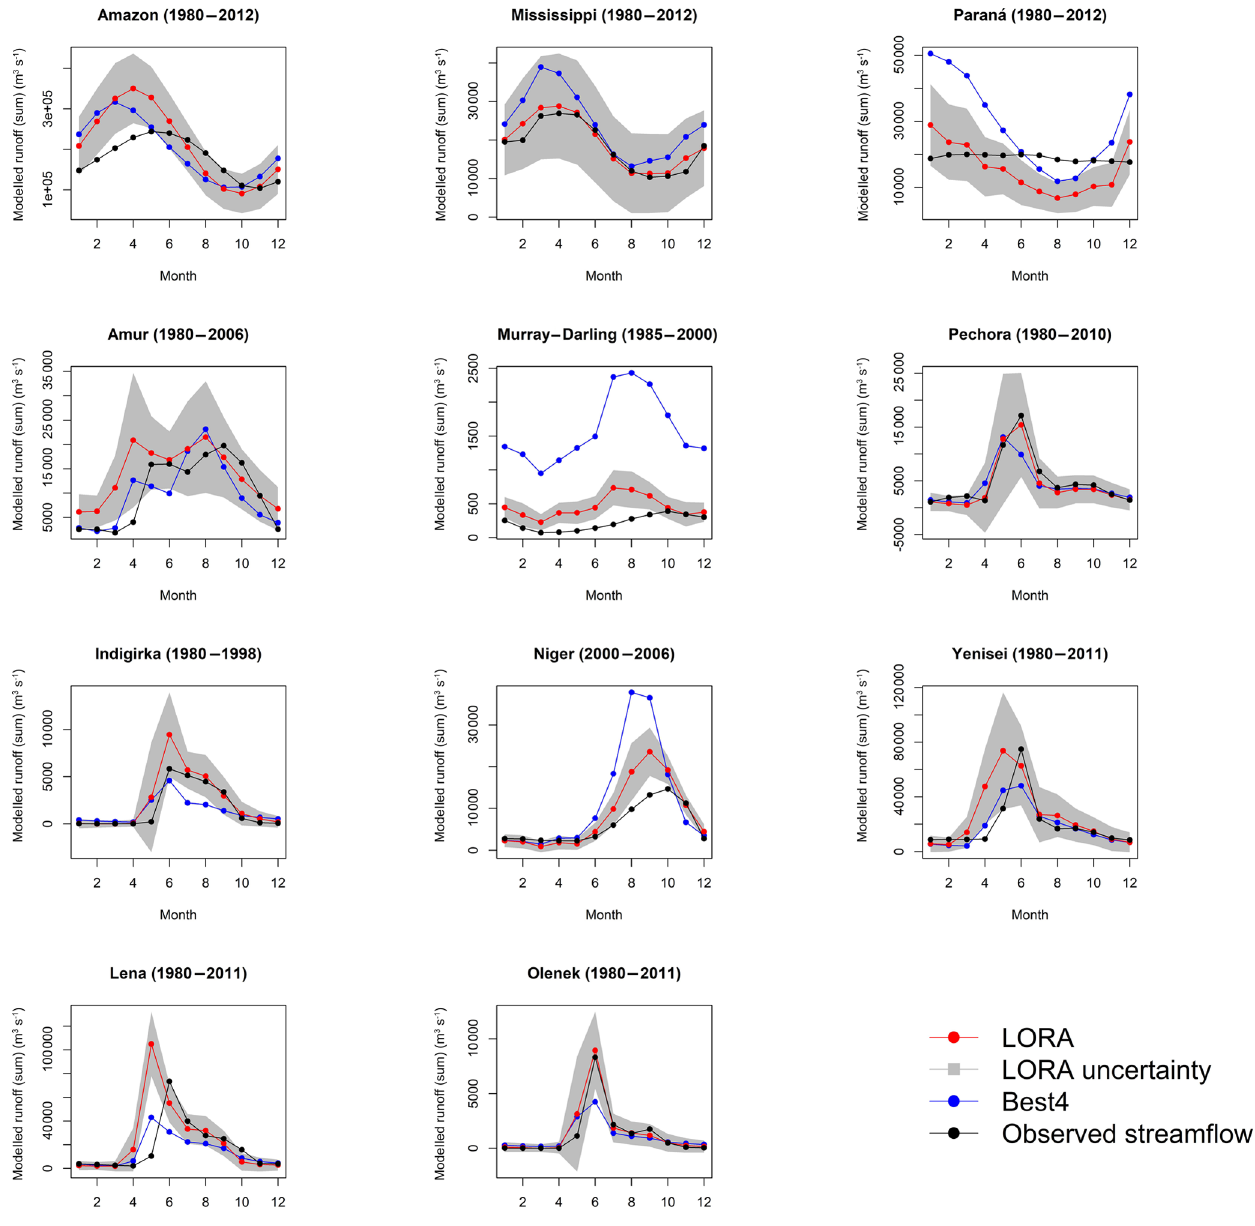
Figure 9. Seasonal cycle of runoff aggregates from LORA and Best4 compared with the observed streamflow over 11 major basins. Runoff aggregates and the observed streamflow were averaged for each month across the period of availability of observation. The shaded regions show the aggregated uncertainty derived for